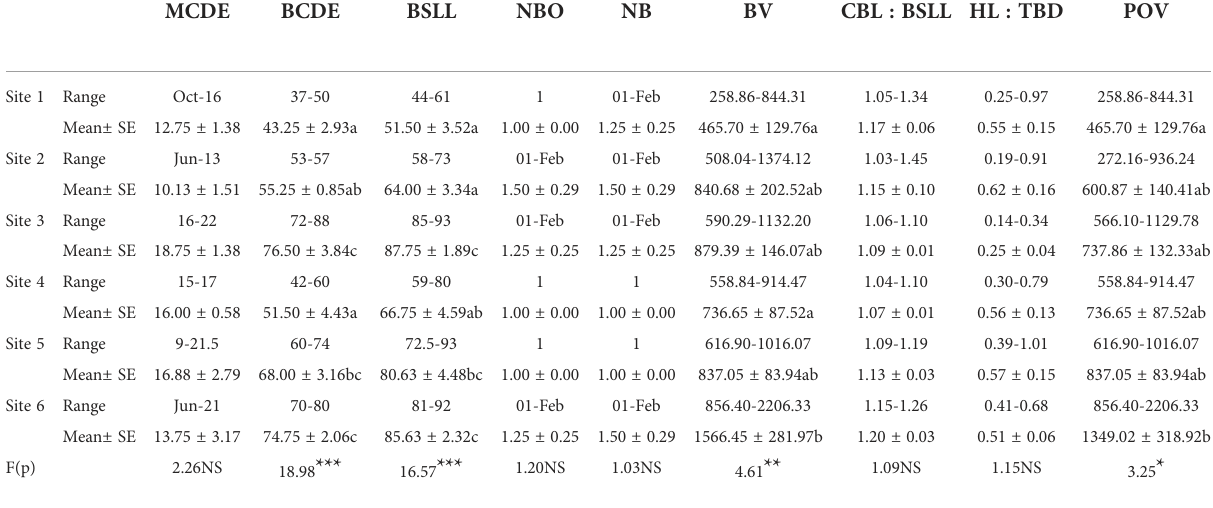
TABLE 1B. Burrow morphology nomenclature of Helice tientsinensis at each